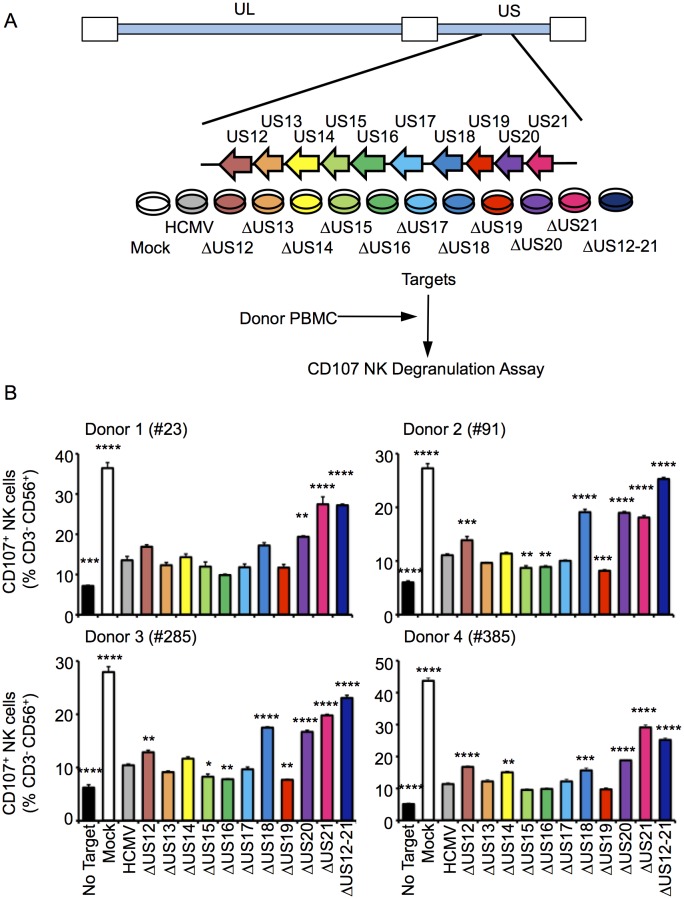
Multiple US12 family proteins regulate NK activation.(A) Fibroblasts (HF-TERTs) were mock infected or infected with the Merlin strain of HCMV or the series of US12 family deletion mutants for 72 hr. Infected cells were incubated with donor PBMC for 5 hr and NK degranulation assessed by % CD107+ cells within the CD3-, CD56+ population by flow cytometry. (B) CD107 assay results (mean and SD) are shown from four separate donors performed in duplicate or triplicate and analysed by unpaired ordinary one way ANOVA with Dunnett’s test for multiple comparisons against the HCMV control *p<0.05, **p<0.01, ***p<0.005 ***p<0.001). Infected cells were assessed by the % cells with down-regulated MHC I compared to the mock-infected cells (for the experiment using donor #23 and # 385, HCMV 93%, ΔUS12 94%, ΔUS13 98%, ΔUS14 94%, ΔUS15 98%, ΔUS16 99%, ΔUS17 98%, ΔUS18 97%, ΔUS19 99%, ΔUS20 97%, ΔUS21 91%, ΔUS12-21 94%; for the experiment using donor #91 and # 285, HCMV 94%, ΔUS12 94%, ΔUS13 94%, ΔUS14 83%, ΔUS15 95%, ΔUS16 97%, ΔUS17 85%, ΔUS18 94%, ΔUS19 96%, ΔUS20 94%, ΔUS21 94%, ΔUS12-21 96%).